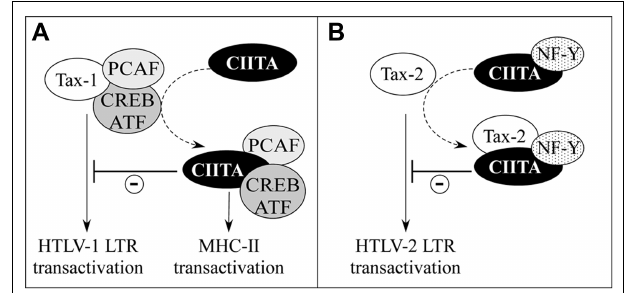
FIGURE 4 | Distinct mechanisms account for CIITA-mediated inhibition of HTLV-1Tax-1 and HTLV-2Tax-2. (A) The cellular factors PCAF and CREB/ATF, required for CIITA-mediated MHC-II transcription, are sequestered by CIITA and are no longer available to interact physically and functionally withTax-1.This results in the inhibition of HTLV-1 LTR transactivation ( − ). (B) CIITA facilitates the interaction betweenTax-2 and NF-Y, an inhibitor ofTax-2 transcription